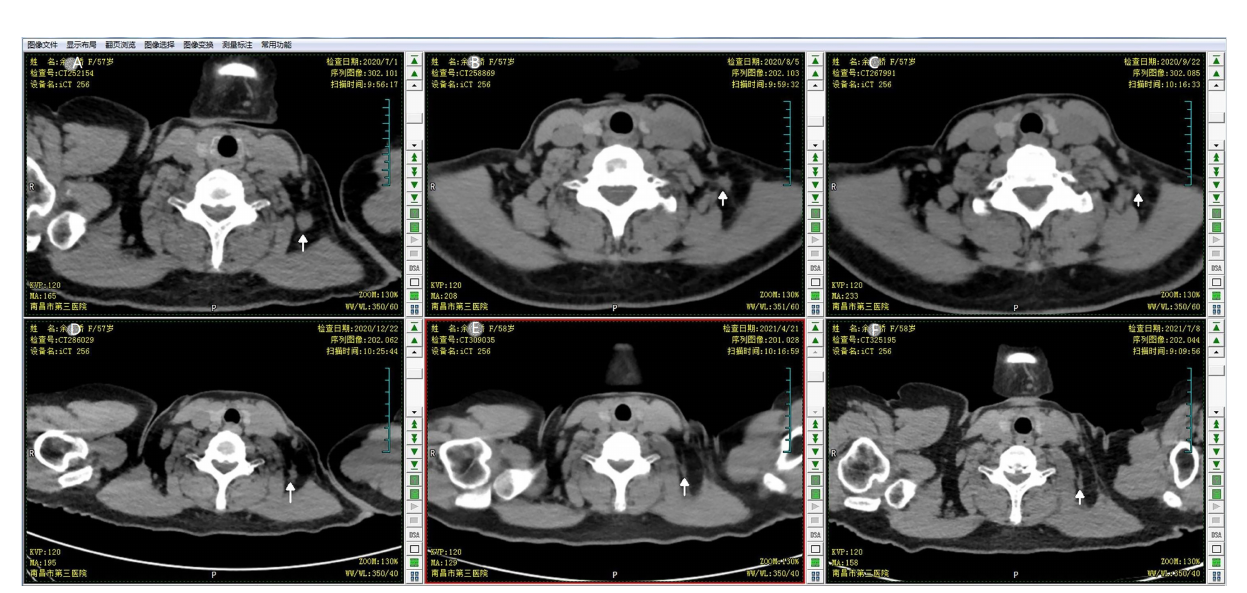
FIGURE 4 | The response of the targeted lymph node to the concomitant fulvestrant with reirradiation. CT scan monitored the continuous response of the breast cancer metastatic neck lymph node during the follow up. (A) CT simulation image prior to the fi rst treatment; (B) CT scan image at end of the 25th fraction of reirradiation; (C) follow-up CT scan at 1 month after the end of reirradiation therapy; (D) follow-up CT scan at 3 months after reirradiation therapy; (E) follow-up CT at 7 months after reirradiation therapy; (F) follow-up CT at 10 months after reirradiation